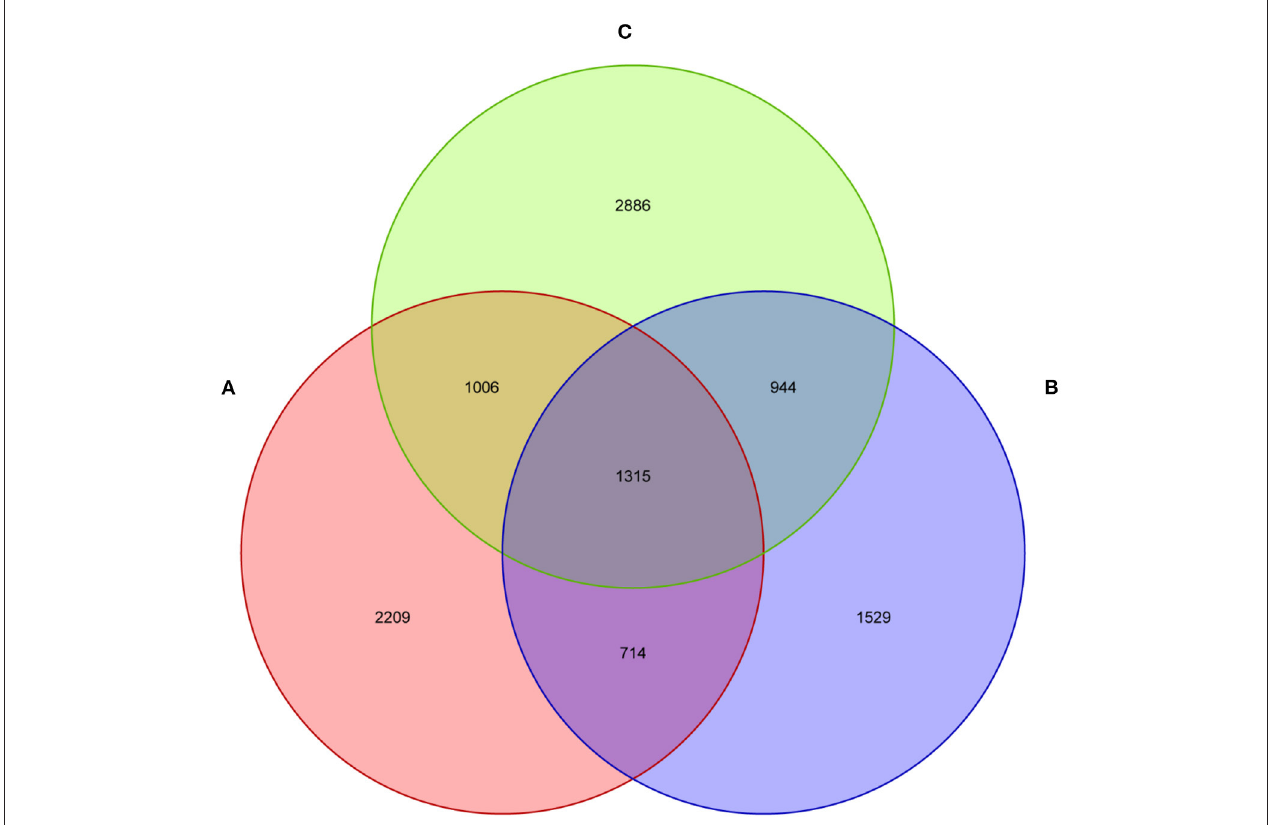
FIGURE 1 | The fecal microflora of weaned piglets, analysed by a Venn diagram. (A) Healthy piglets; (B) Diarrheal piglets; (C) Treated